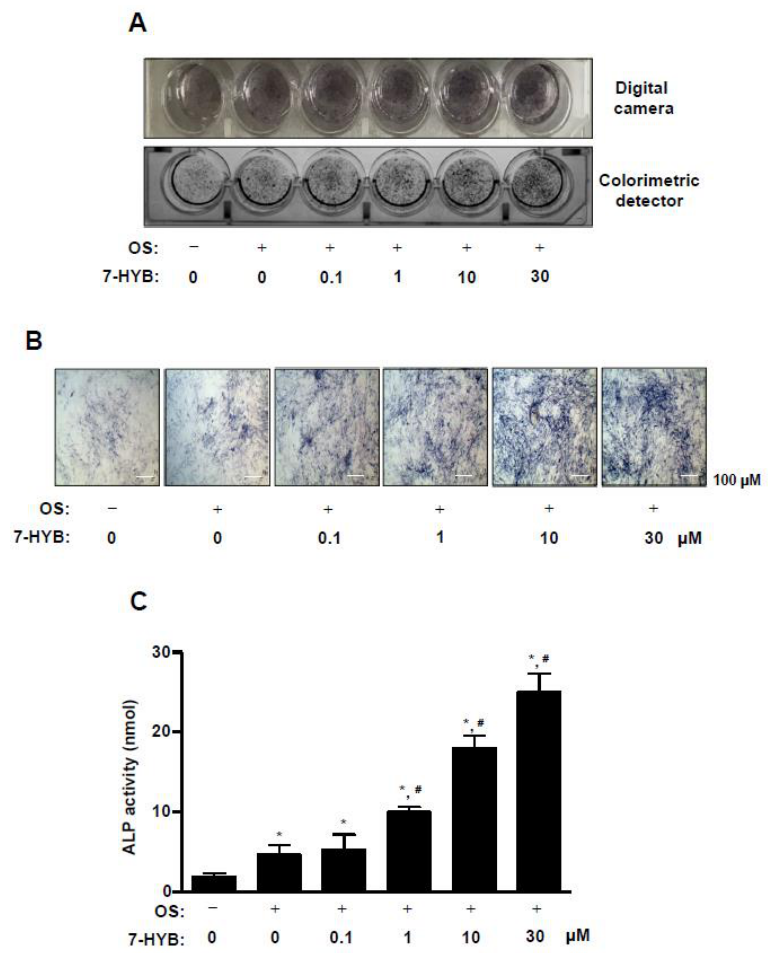
Figure 2. Effect of 7-HYB on the early osteoblast differentiation. ( A , B ) Preosteoblasts were cultured in osteogenic supplement medium (OS) containing 50 μg/mL L-ascorbic acid (L-AA) and 10 mM β-glycerophosphate (β-GP) with 0.1, 1, 10, and 30 μM of 7-HYB for seven days. The staining of alkaline phosphatase (ALP) was detected using a digital camera ( top ) and colorimetric detector ( bottom ) (A), the individual ALP-stained cells were observed under a light microscope (B). ( C ) ALP activity was measured at 405 nm by the Multiskan GO Microplate Spectrophotometer. Scale bar: 100 µ m. Data represent the mean ± S.E.M. of experiments. *, p < 0.05: statistically significant difference when compared to the control. #, p < 0.05: statistically significant difference when compared to OS.